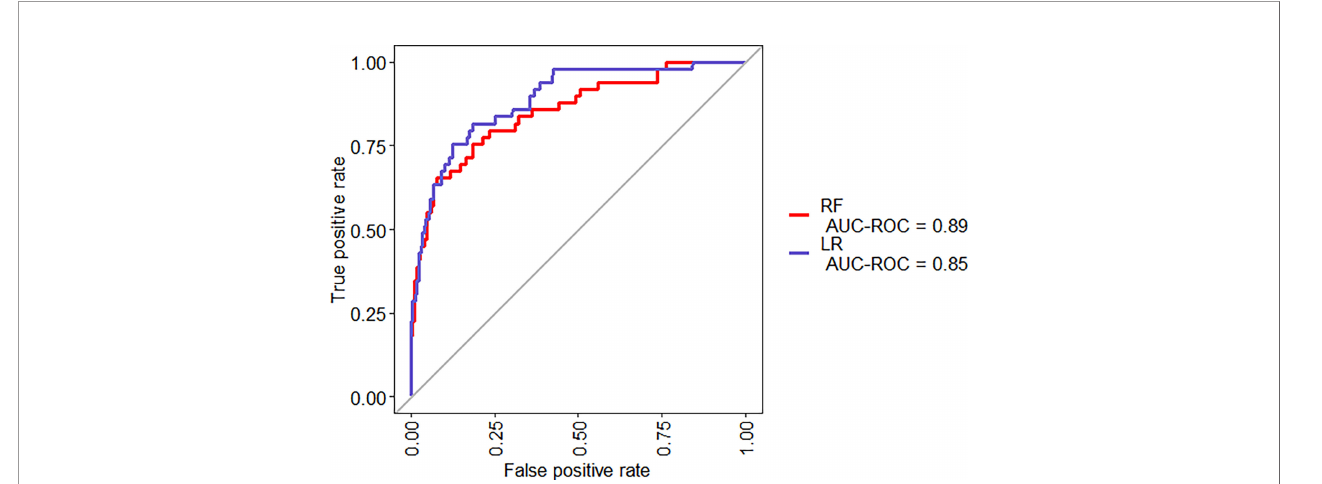
FIGURE 3 | ROC curves for the RF and LR models, for a tenfold cross-validation on the training set.